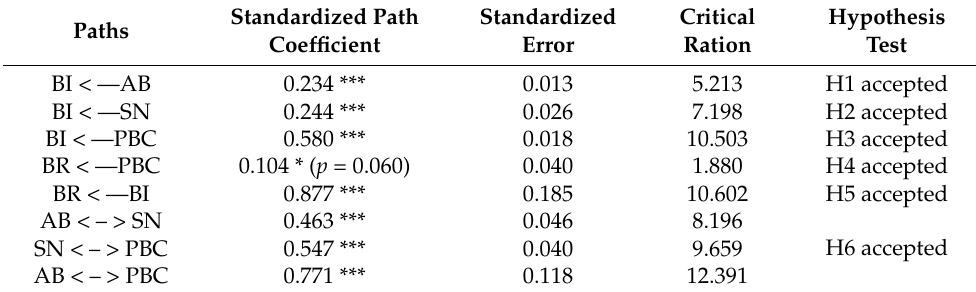
Table 6. Estimation results of the